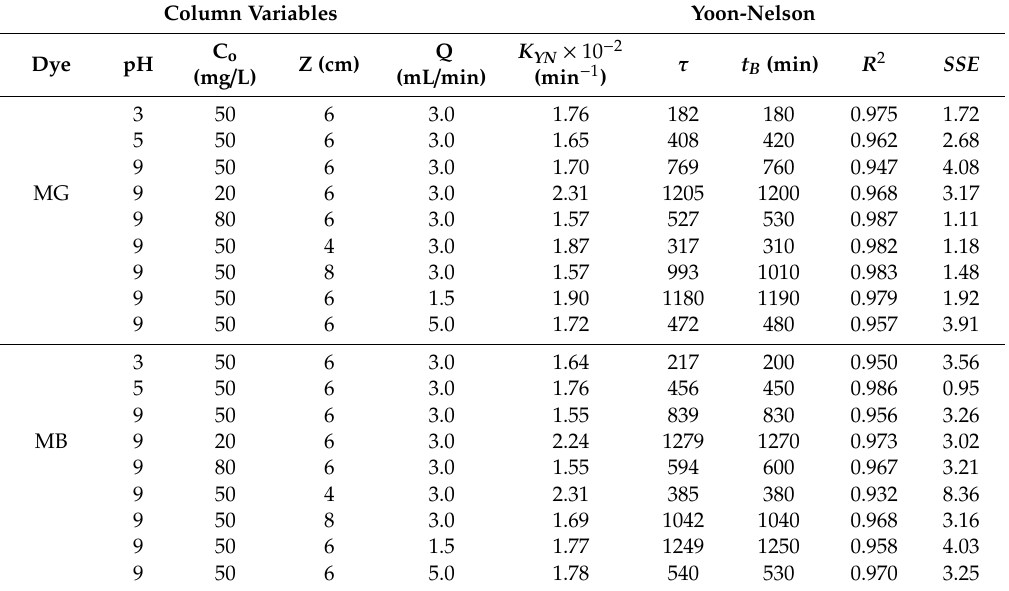
Table 7. Yoon-Nelson model constants and statistical parameters for MG and MB adsorption by T-PAA at di ff erent column conditions.